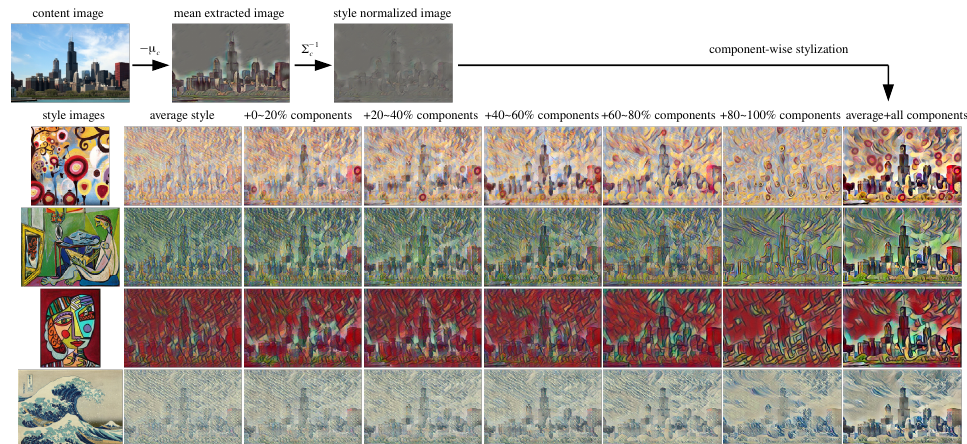
Figure 5. Examples of style-specific average and style components: The images on the first row represent the decoded images of features in style normalization procedure. The remaining rows of images show the average stylized images and their variations with some style components corresponding to each style image. The images on the third column are with style components corresponding to the lower 20% of the total eigenvalues of feature covariance and the images on the seventh column corresponding to higher 20%. The lower style components make subtle changes in the stylized image while the higher style components change the style of image largely from the average style. The right-most column of images represents the fully stylized images.